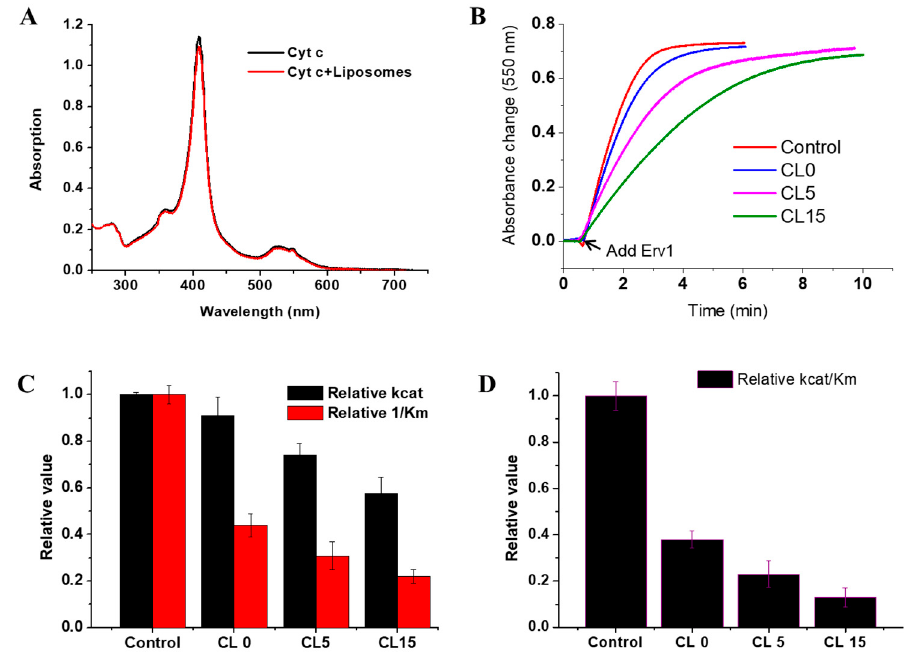
Figure 5. Effects of liposomes on the cytochrome c reductase activity of Erv1. ( A ) Absorption spectra of cytochrome c in the absence and presence of CL15 liposomes. The same spectra were obtained with CL0 and CL5 liposomes (data not shown) ( B ) Time course of cytochrome c reduction, followed by absorbance at 550 nm. ( C ) Relative enzyme kinetic parameters of cytochrome c reductase activity, k cat (black) and relative 1/K m (red). ( D ) The relative cytochrome c reductase catalytic efficiency of Erv1. Control: the reaction without liposomes. DTT (1 mM) and liposomes (0.5 mM) were used in all cases. The error bars represent the SEM, n = 3; differences between each result and the corresponding